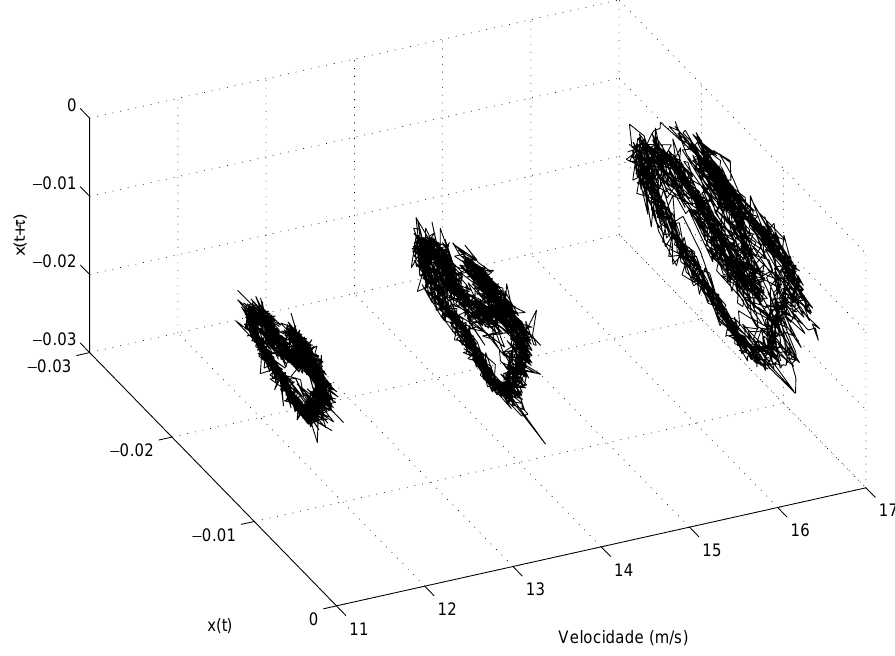
Fig. 7. Reconstructed state spaces of torsional measurements with freestream velocity variation (cases 2, 4 and 6 from Table 2).